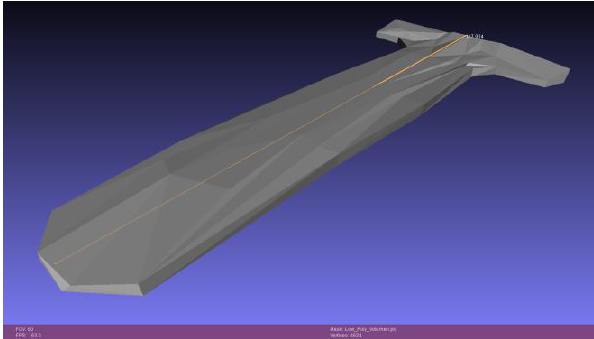
Figure 7. Spatial plausibility hull (CropHull) for groyne 31,